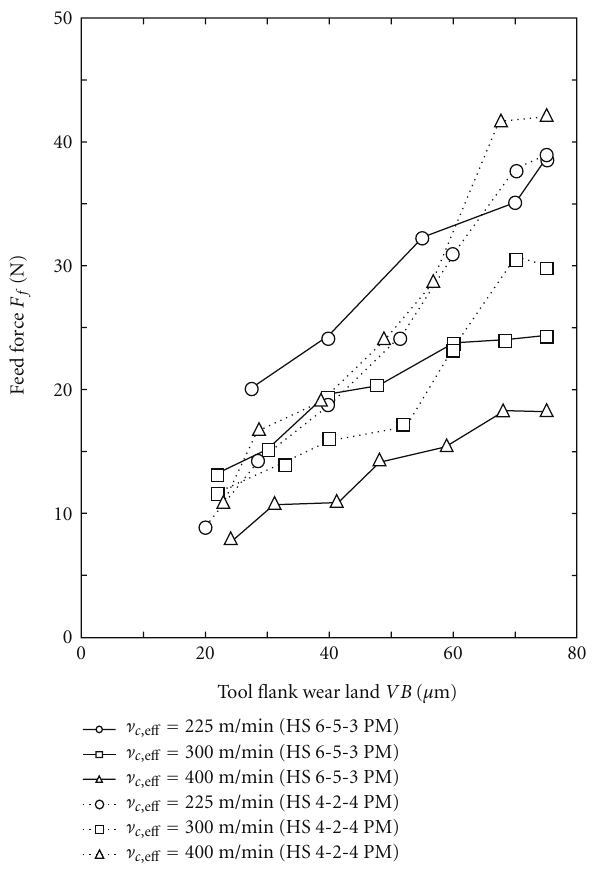
Figure 16: Influence of varied work piece material and progressing tool flank wear land on the resulting feed